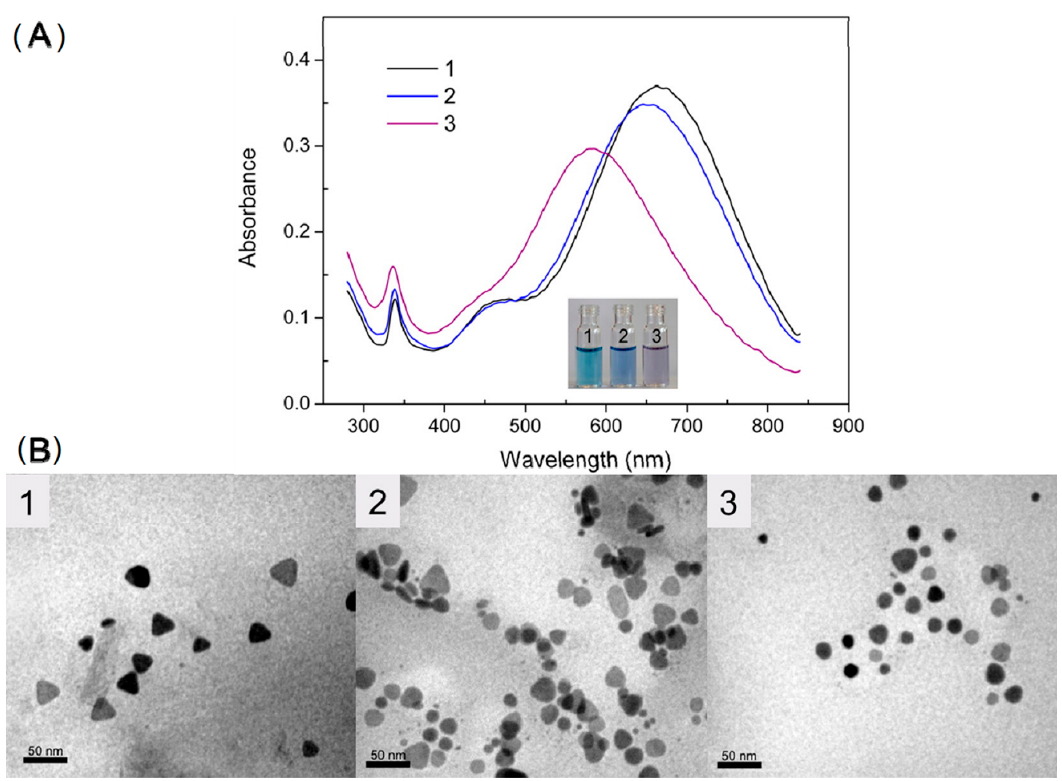
Figure 7. ( A ) UV-Vis spectra of (1) silver nanoprisms, (2) with 700 nM of Hg (II) and (3) with 1500 nM of Hg (II). ( B ) TEM images of (1) AgNPs, (2) with 700 nM of Hg (II) and (3) with 1500 nM of Hg (II) [116].